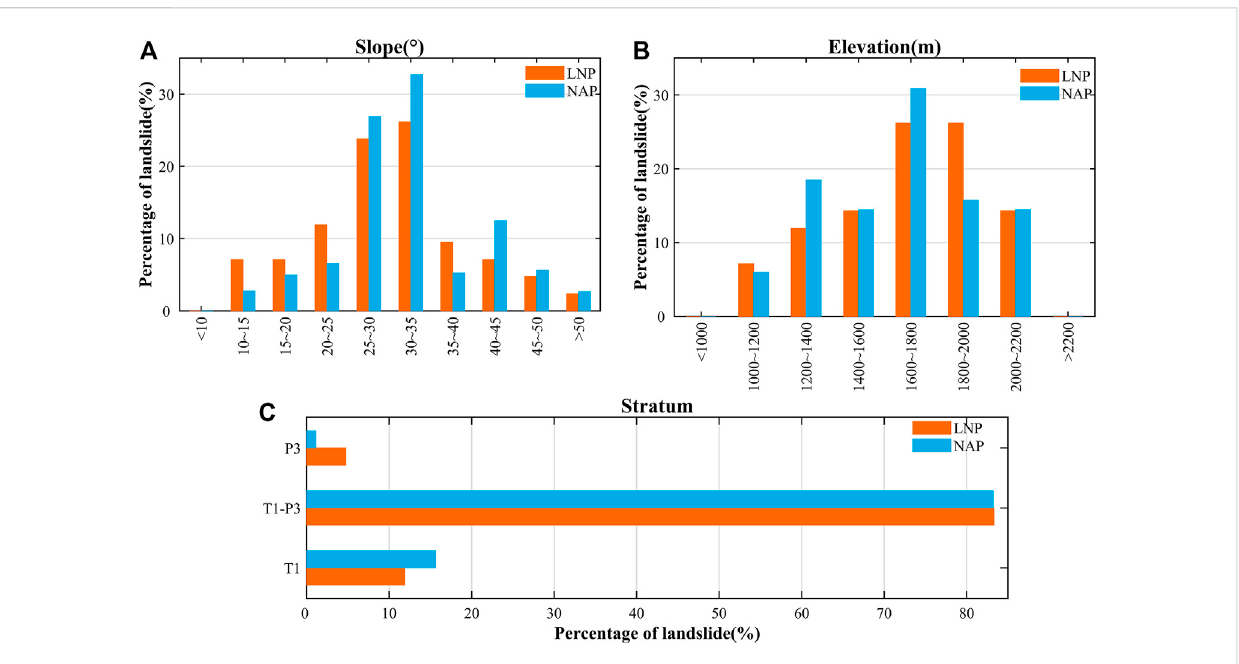
FIGURE 6 Statistics of geomorphological elements of mining-induced active landslides in the study area; Distribution ratio of (A) slope; (B) elevation; (C) stratum.